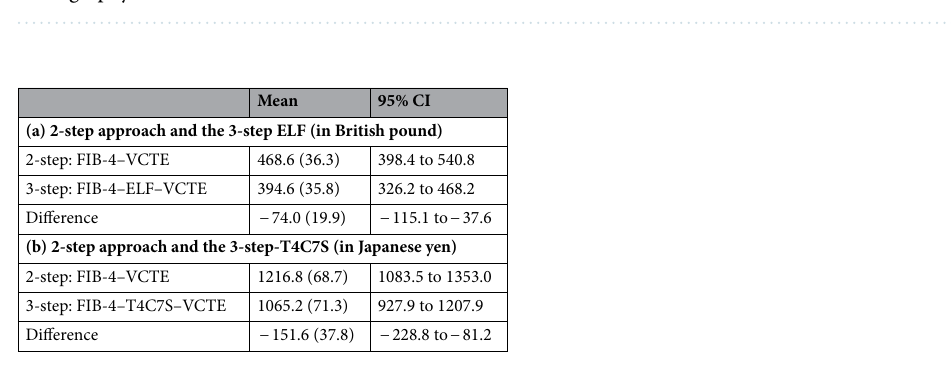
Table 3. Diagnostic performance of each approach for predicting advanced fibrosis in cohort with a 3.7% prevalence of advanced fibrosis. Upper line indicates mean ± SD, and lower line indicates 95% CI. Bold letters indicate a significant difference compared to the 2-step approach. CI, confidence interval; ELF, enhanced liver fibrosis test; FIB-4, Fibrosis-4 index; NPV, negative predictive value; PPV, positive predictive value; Se, sensitivity; Sp, specificity; T4C7S, type IV collagen 7S domain; VCTE, vibration-controlled transient elastography.